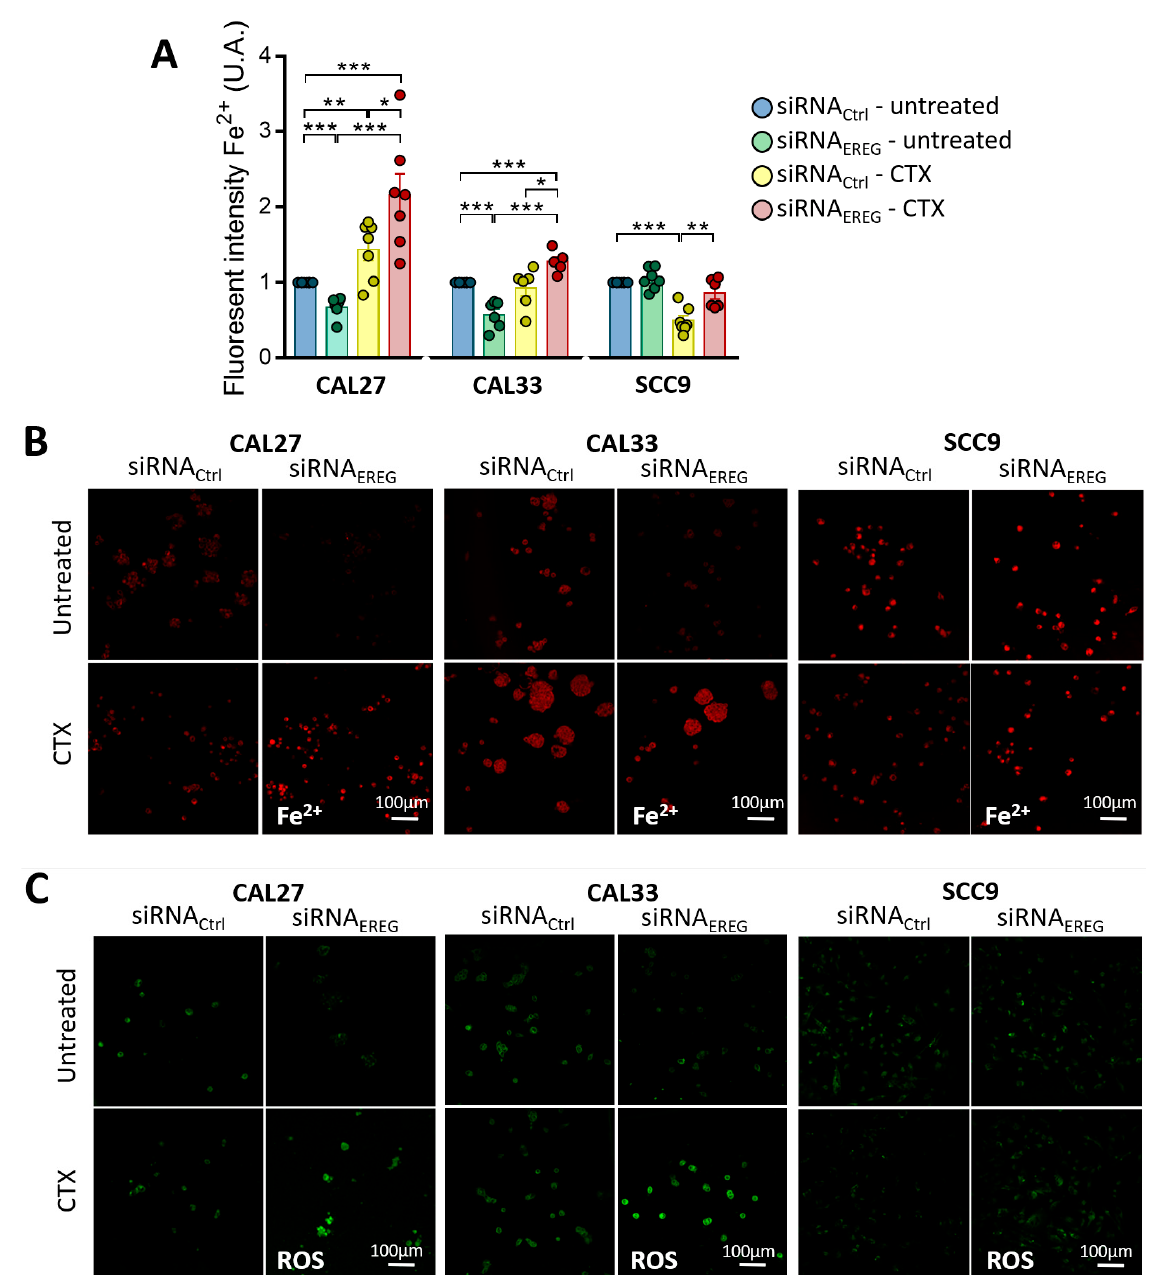
Figure 3. ( A ) Histograms showing the levels of intracellular Fe 2+ measured in CAL27, CAL33 and SCC9 cells transfected with siRNA Ctrl or siRNA EREG and treated with solvent or 30 nM CTX. Data are represented as the mean ± SEM of intracellular Fe 2+ intensity ( n = 8, with * p < 0.05, ** p < 0.001 and *** p < 0.0001). Pictures show ( B ) the intracellular Fe 2+ production (in red, staining of individual CAL27 and SCC9 cells or clustered CAL33) and ( C ) the lipid peroxidation (in green) acquired by confocal microscopy in CAL27, CAL33 and SCC9 cells transfected with siRNA Ctrl or siRNA EREG and treated with solvent or 30 nM CTX (scale bar: 100 µm).